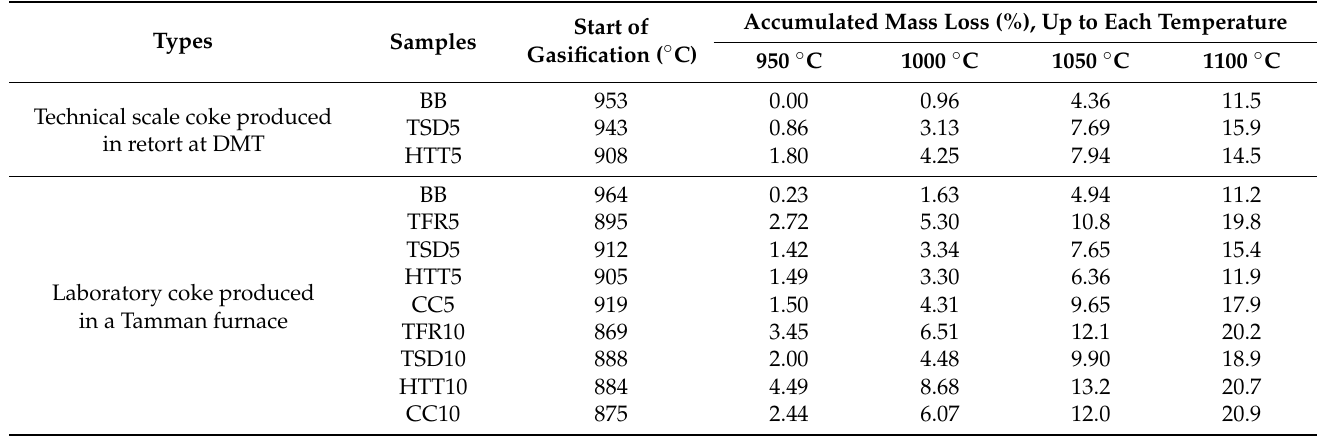
Table 9. Temperature for the start of gasification and accumulated mass loss at different temperatures, as measured in TGA. Types